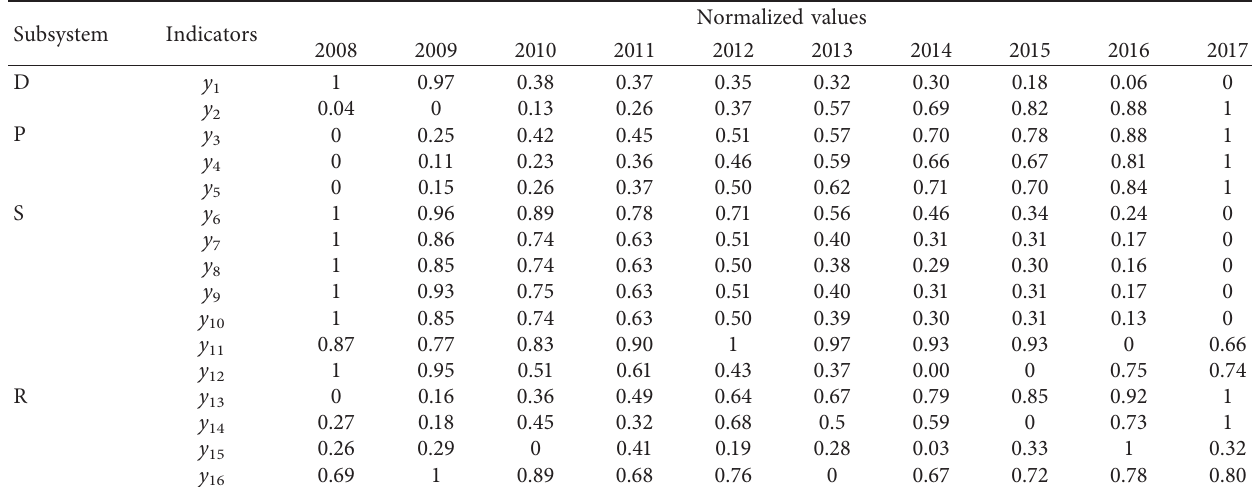
Table 2: The normalized values of 16